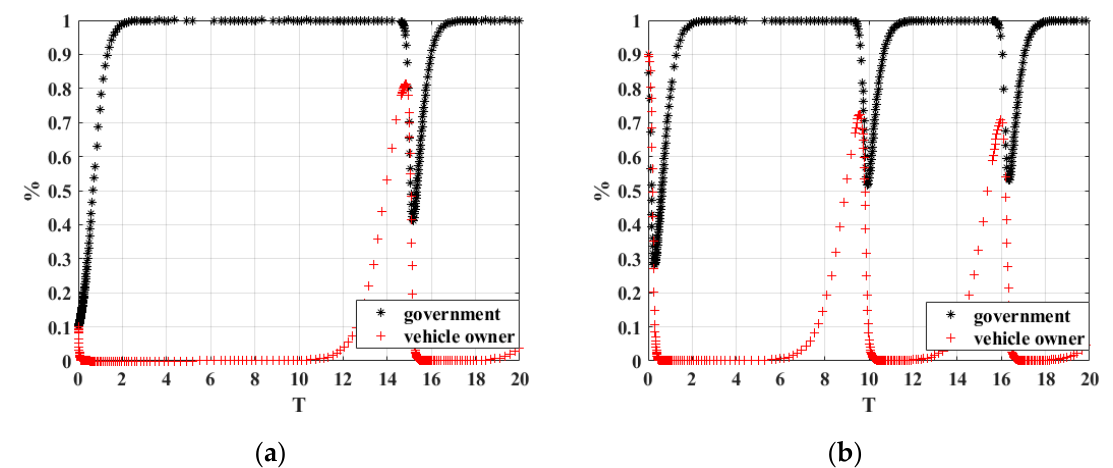
Figure 2. Simulation results with different initial probabilities. ( a ) Initial probability of (0.1, 0.1); ( b ) Initial probability of (0.9, 0.9).